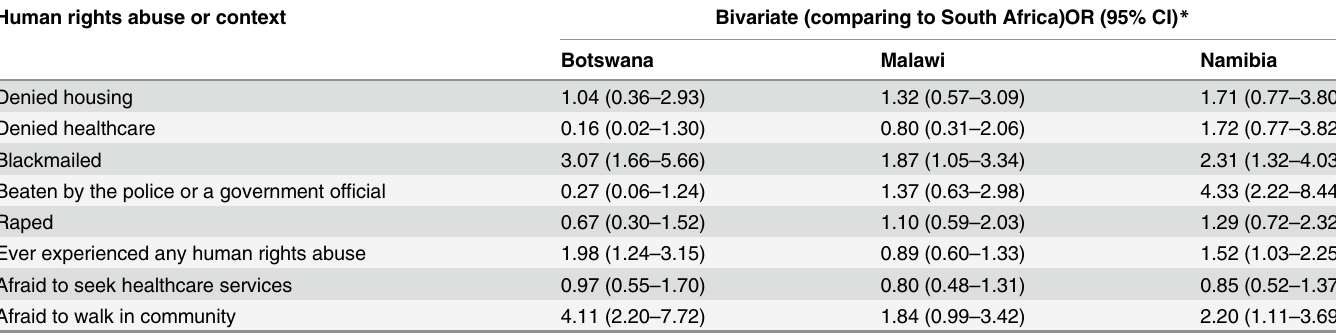
Table 3. Bivariate regression analyses of differences by country in human rights abuses reported by